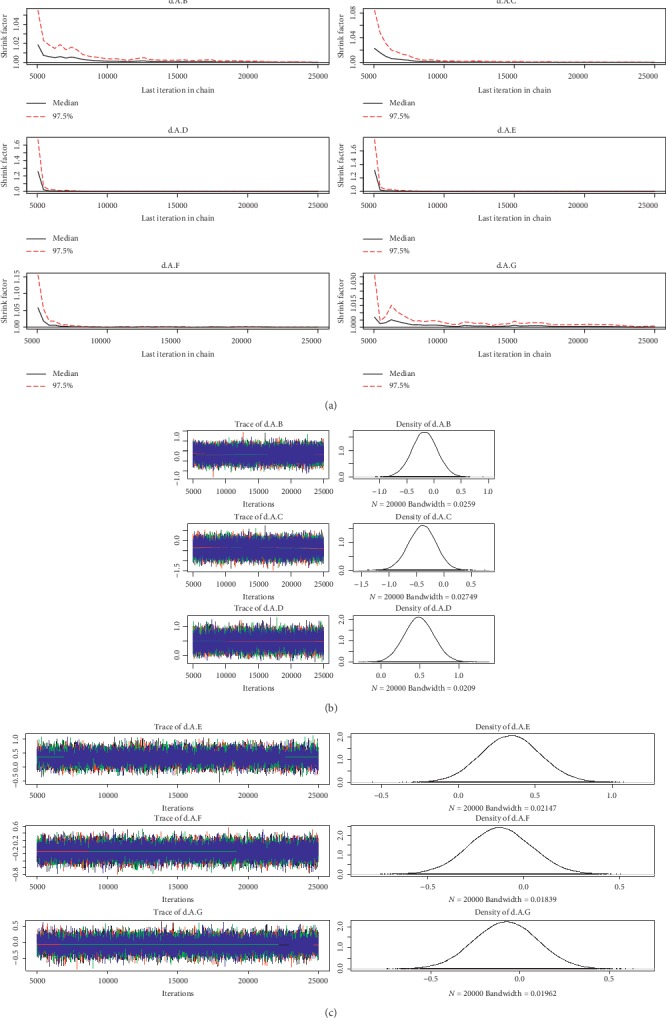
Brooks-Gelman-Rubin diagnostic plot and density plot for the efficacy of the comparison among different treatments of patients with normal renal function (A: warfarin; B: dabigatran110; C: dabigatran150; D: edoxaban30; E: edoxaban60; F:apixaban; G:rivaroxaban).